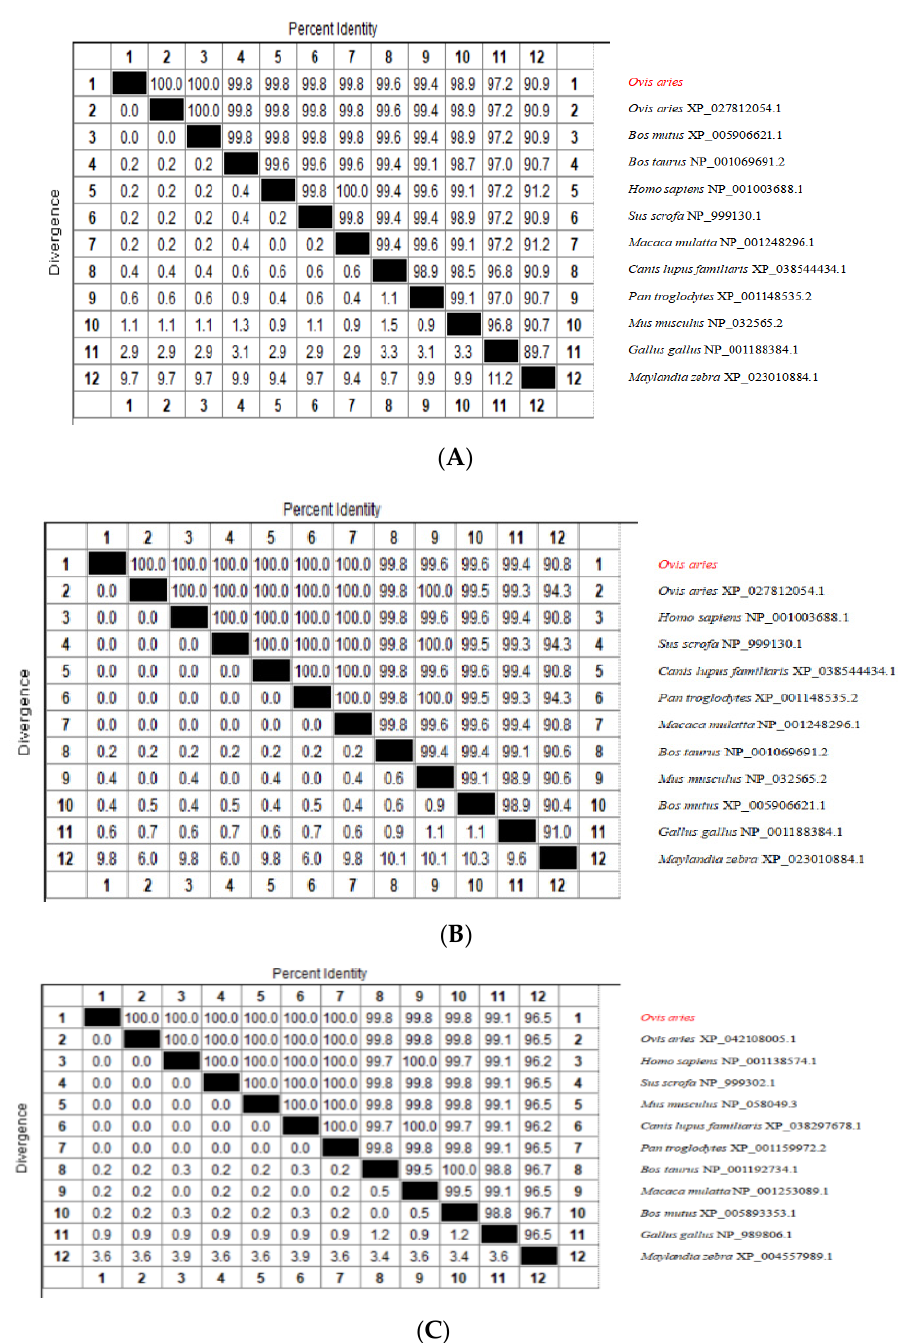
Figure 1. SMAD1 ( A ), SMAD2 ( B ) and SMAD3 ( C ) polypeptide sequence identity of Tibetan sheep with 11 other species. The red highlight text is the species studied in this article.